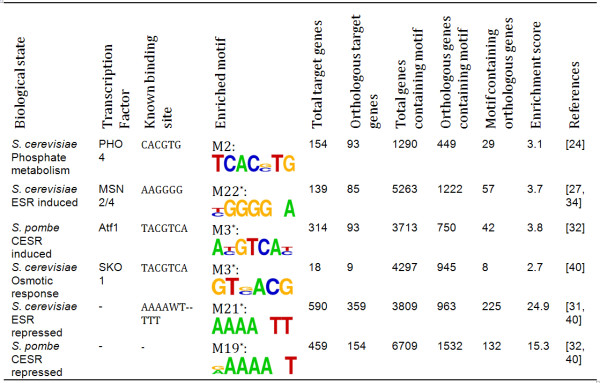
Conservation of both binding site and target genes between Fusarium and yeast. We found 2573 genes out of total 13332 Fg genes (19%) with orthologous pairs in Sc by BLAST program (1e-5). Similarly, we found 2378 Fg genes (18%) with orthologous pair in Sp. We checked the presence of our motifs enrichment in the functional sets of genes identified through previous studies (references in the last column) or by their sequence similarity to transcription factors (Figure 4). * indicates that the corresponding motif is also the most significantly enriched motif among all discovered degenerate motifs for the set.